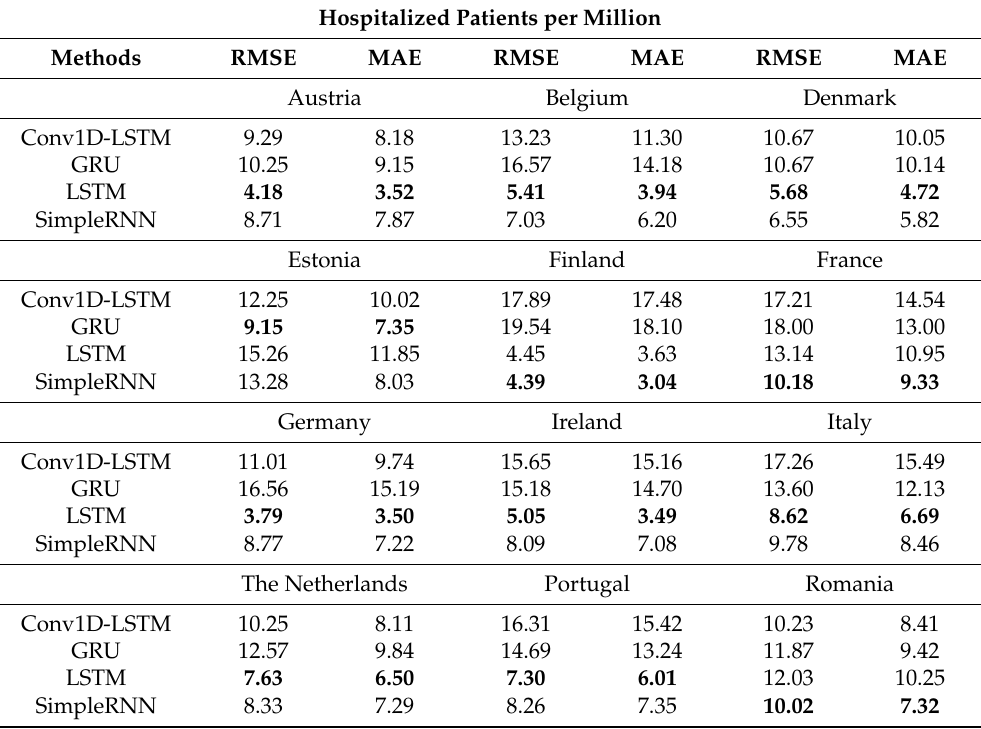
Table 6. Errors for HOSP-Patients per Million for each country per method. Bold values show the minimum errors per country.